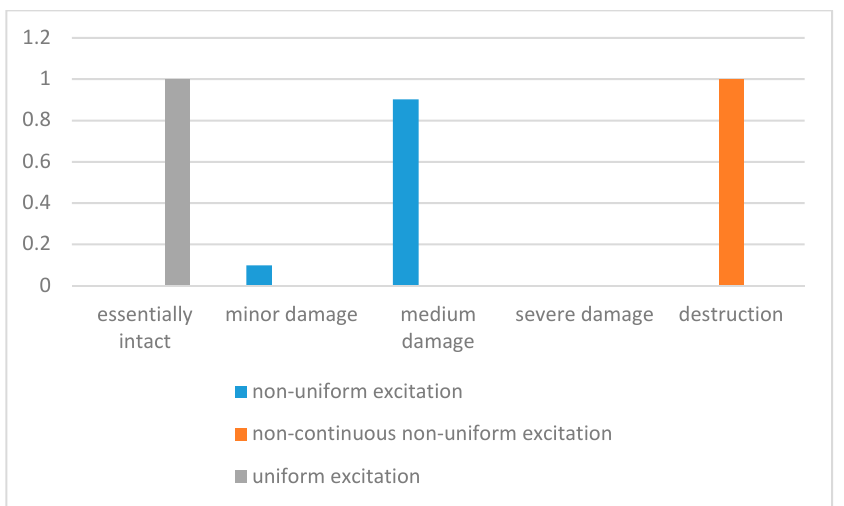
Figure 11 Fuzzy damage of three working conditions. Figure 11. Fuzzy damage of three working